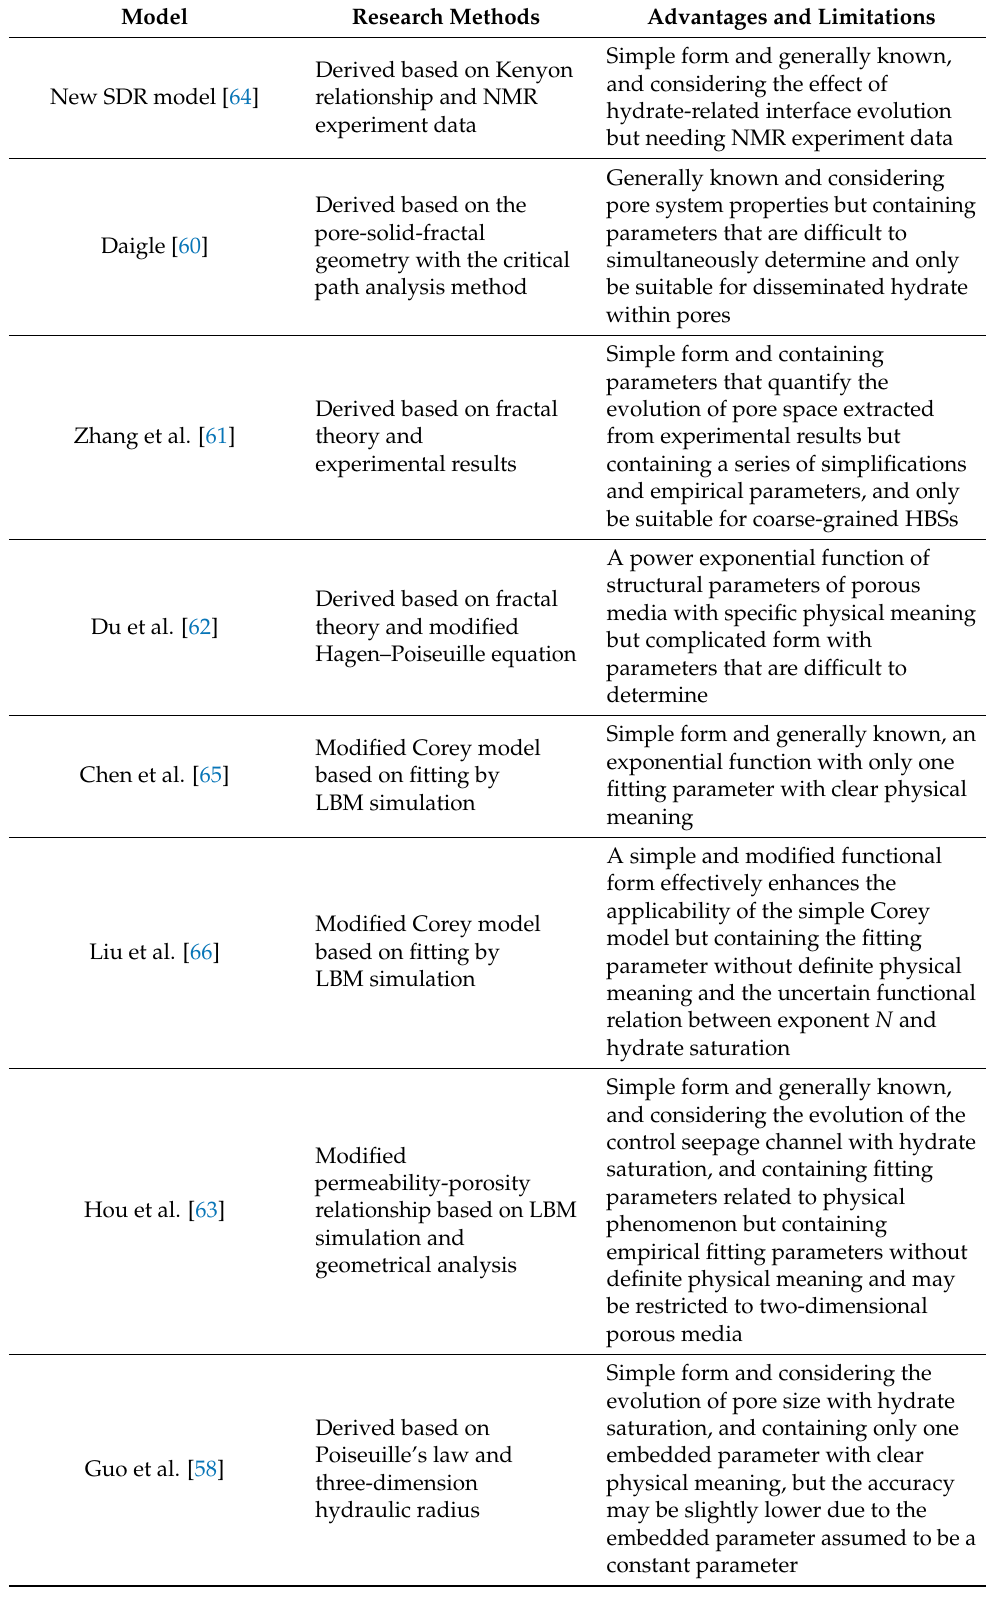
Table 7. Research methods, advantages, and limitations of novel permeability models for permeability prediction of